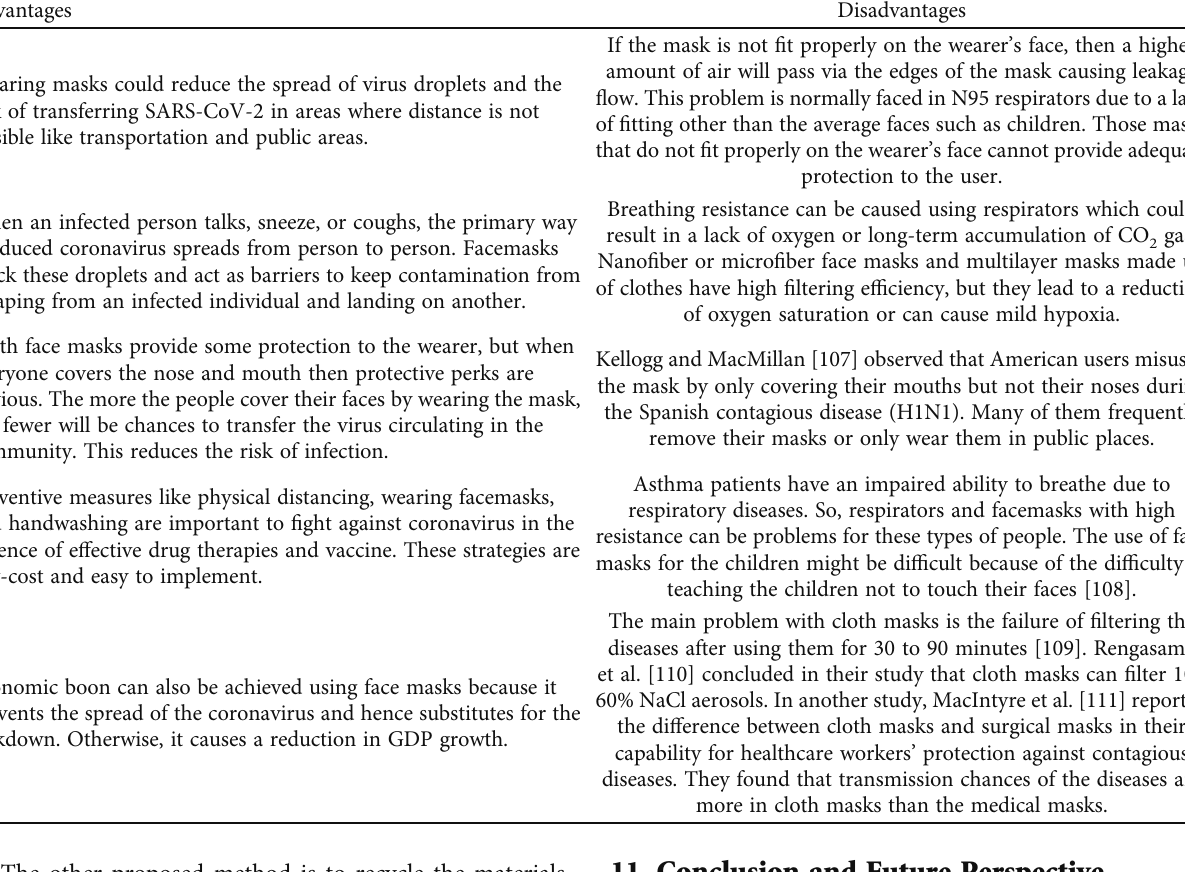
Table 4: Advantages and disadvantages of face